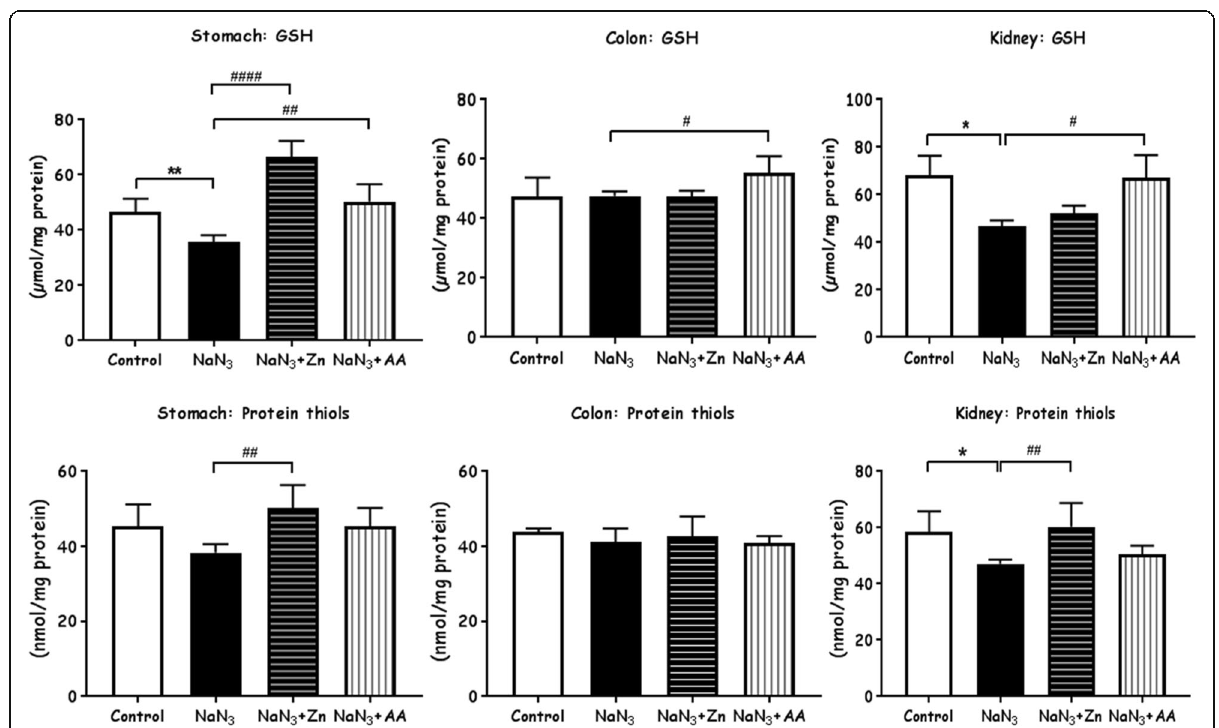
Fig. 4 The effects of Zn sulphate (Zn) and AsA (AA) on reduced glutathione (GSH) and protein thiol levels in stomach, colon and kidney of rats treated with sodium azide (NaN 3 ). Values are given as mean ± standard deviation ( n = 7). Significant differences: *NaN 3 ; NaN 3 + Zn; NaN 3 + AA versus control group (* p < 0.05; ** p < 0.01; *** p < 0.001; **** p < 0.0001). # NaN 3 + Zn; NaN 3 + AA versus NaN 3 group ( # p < 0.05; ## p < 0.01; ### p < 0.001; #### p <